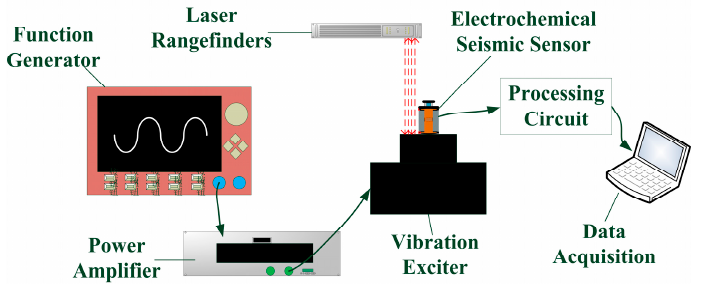
Figure 3. The schematic of the experimental platform where the developed seismic sensor was positioned on a vibration exciter, which is excited electrically (function generation and power amplifier) and detected optically (laser rangefinder).